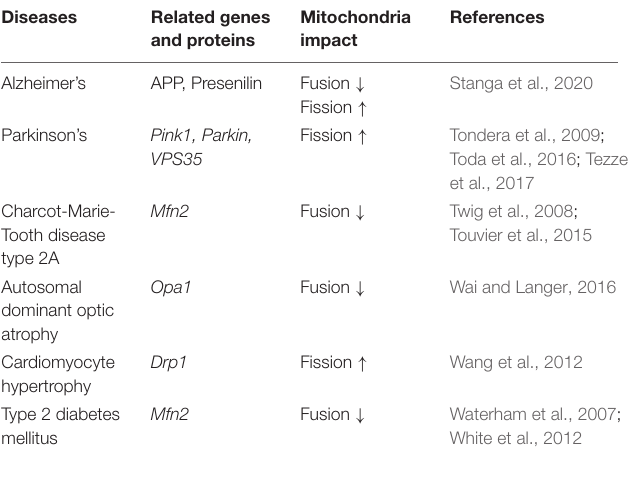
TABLE 2 | Common diseases related to mitochondria